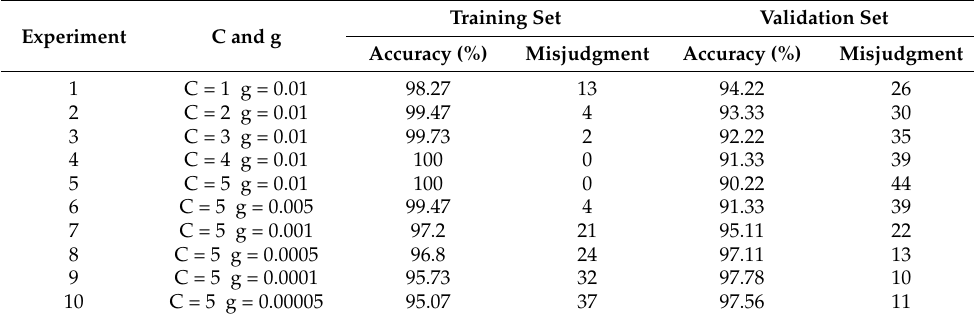
Table 2. Results of SVM model with different C and g